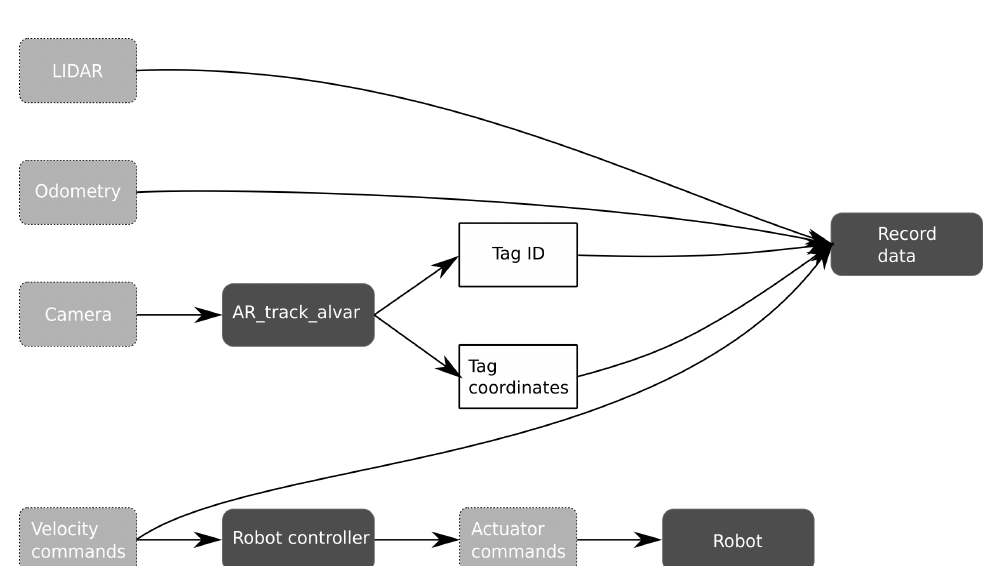
Figure 4. Overview of data flow during manual